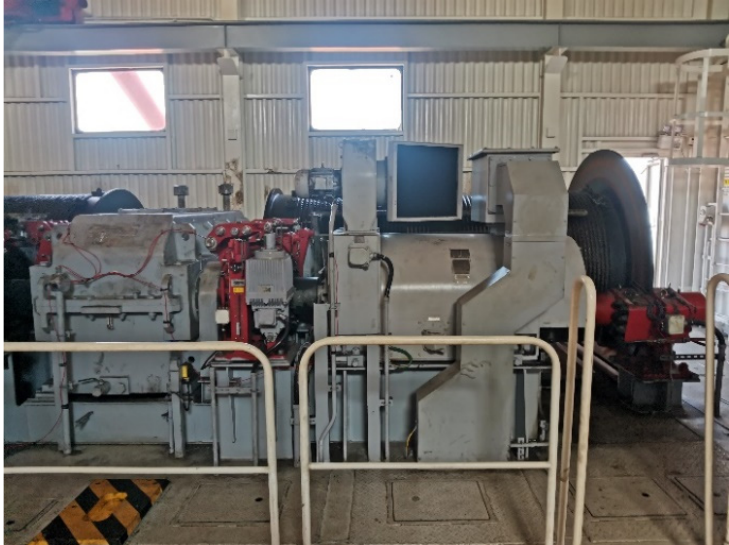
Figure 5. The target mechanism to be monitored.